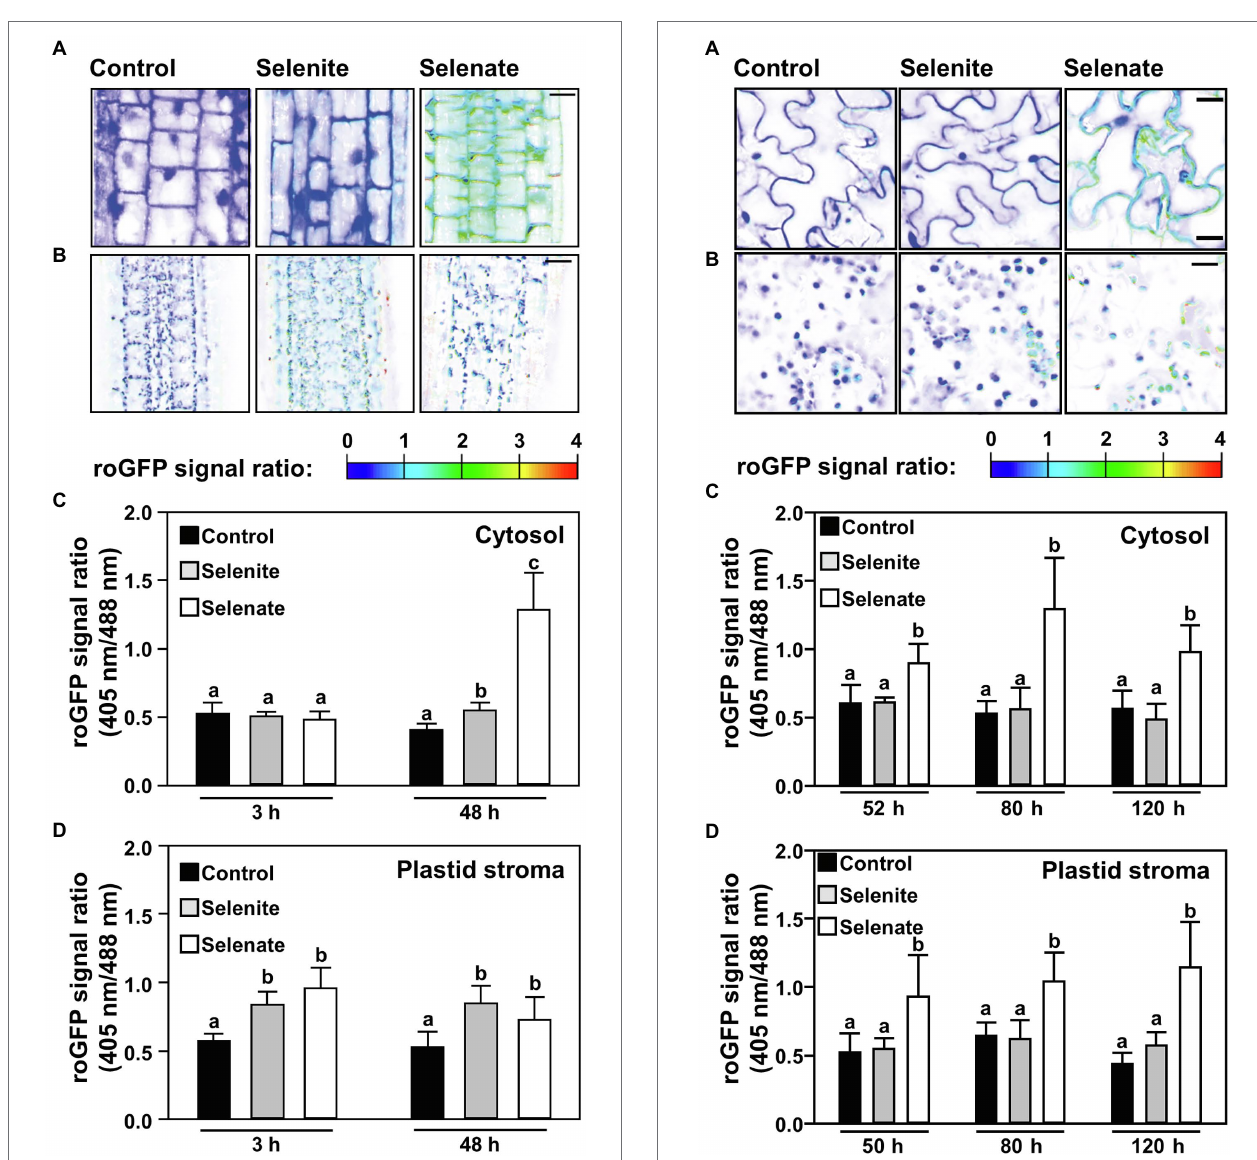
FIGURE 5 | Time-resolved impact of selenium species on the cytosolic and the plastid glutathione redox state in roots of Arabidopsis. (A,B) Representative false-color images of the Grx1-roGFP2 signal ratio in the cytosol (A) or plastids (B) of roots treated with selenite, selenate or without additional selenium supply for indicated time points. Arabidopsis plants expressing the Grx1-roGFP2 sensor in the cytosol or plastids were treated for up to 2 days in ½ Hoagland medium (control), supplemented with either 50 μ M Na 2 SeO 3 (selenite) or 50 μ M Na 2 SeO 4 (selenate). roGFP2 was excited at 405 nm and 488 nm, respectively, and fluorescence was collected at 505– 530 nm. The 405/488-nm fluorescence ratio is shown on a false-color scale spanning full reduction of roGFP2 (blue) to full oxidation (red). Images were digitally enhanced for comparison. Scale bar = 20 μ m. (C,D) The roGFP2 fluorescence ratio is indicating relative changes in the glutathione redox potential in the cytosol (C) or the plastid stroma (D) of roots treated for indicated times with ½ Hoagland medium (control, black bars), supplemented with selenite (gray bars) or selenate (white bars). Data are shown as mean values ± SD. Different lowercase letters indicate individual groups identified by pairwise multiple comparisons with a Holm-Sidak one-way ANOVA ( p = 0.05, n = 5–15).